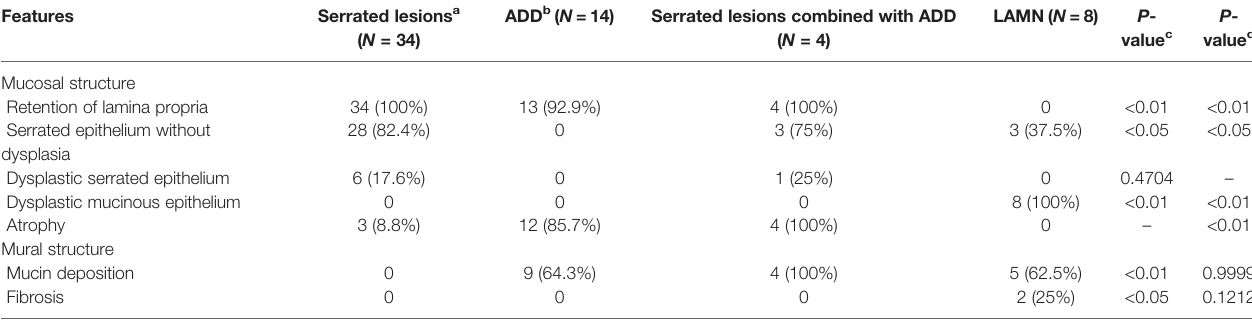
TABLE 4 | Pathological features of appendiceal serrated lesions, ADD, and LAMN in the entirely submitted